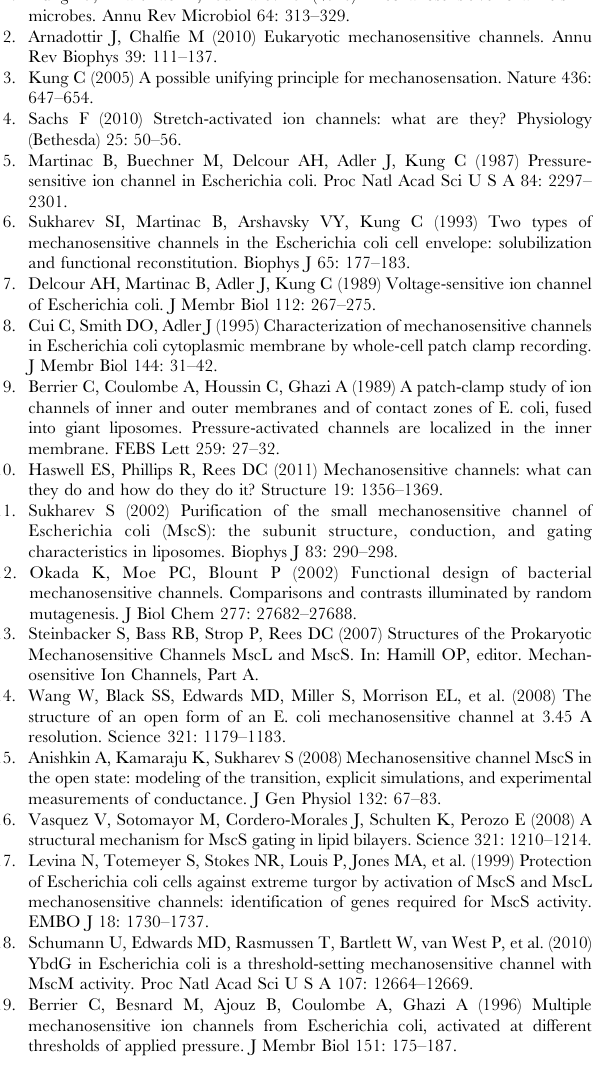
Table S1. Oligonucleotides used in this